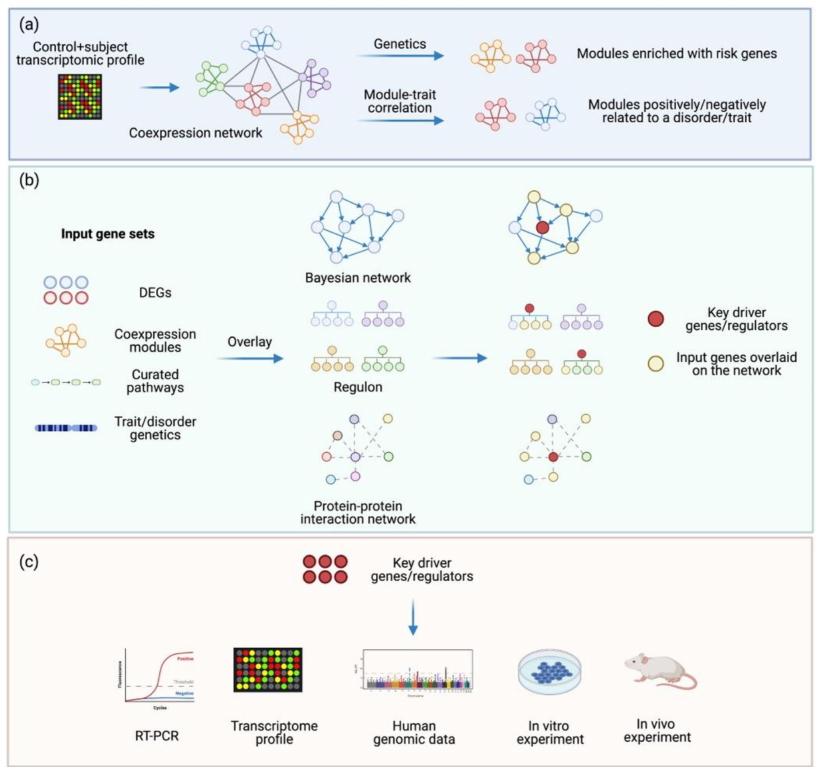
Figure 3. Using networks to identify disorder-related networks and key driver genes. ( a ) The